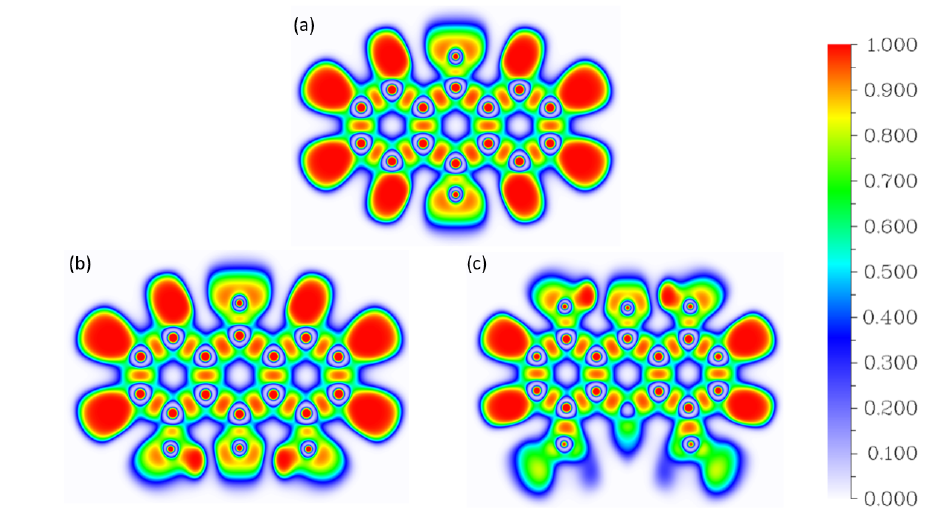
Figure 5. 2D maps of Electron Localization Function (ELF) for the studied compounds ( a ) 1 , ( b ) 2 and ( c ) 3 codified by colors in a range form 0 (purple) to 1 (red). The ELF was calculated at the B3LYP/6-311+G(d) level of theory.